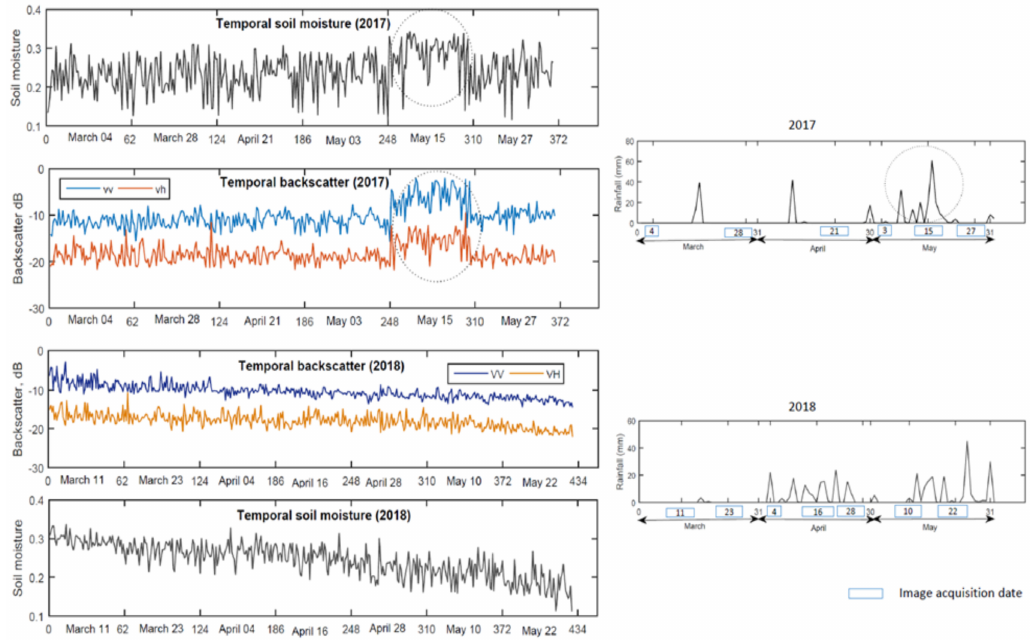
Figure 8. Temporal soil moisture, backscatter, and rainfall, 2017–2018 (March to